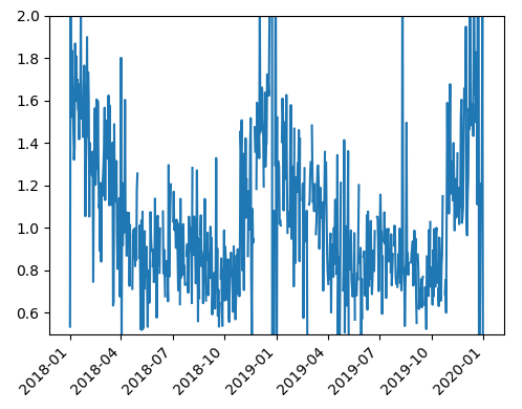
Figure 12. Aggregated occupancy ratio R agg between 2018-01-01 and 2019-12-31, estimated with the C/DiffT method, adjusted for weekly patterns.